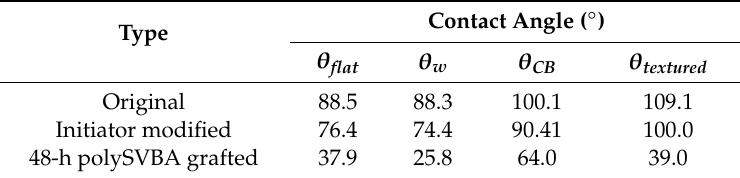
Table 1. Contact angle of experimental results ( θ textured ) and values calculated from Wenzel model ( θ w ) and Cassie–Baxter model ( θ CB ) for di ff erent type surfaces.